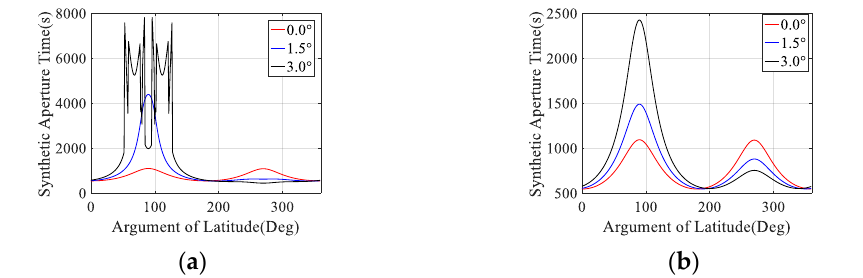
Figure 7. Synthetic aperture time along the orbit. ( a ) With the consideration of variations of the RLS; ( b ) without the consideration of variations of the RLS.